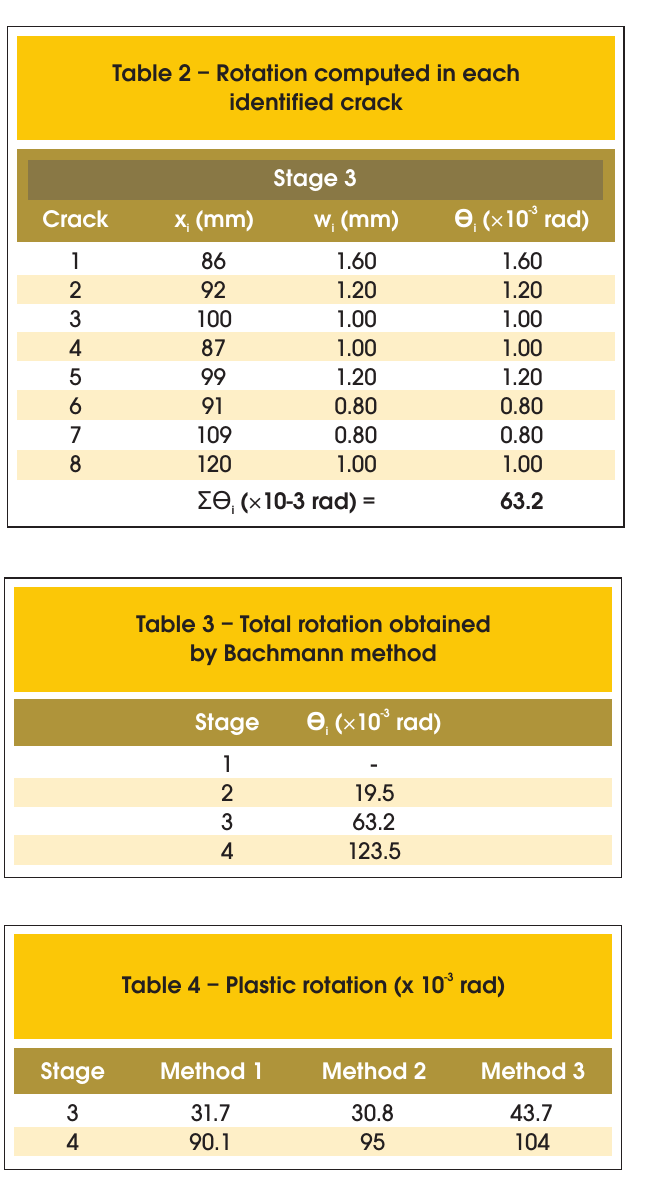
Figure 15 – Average curvature in the monitored region (stage